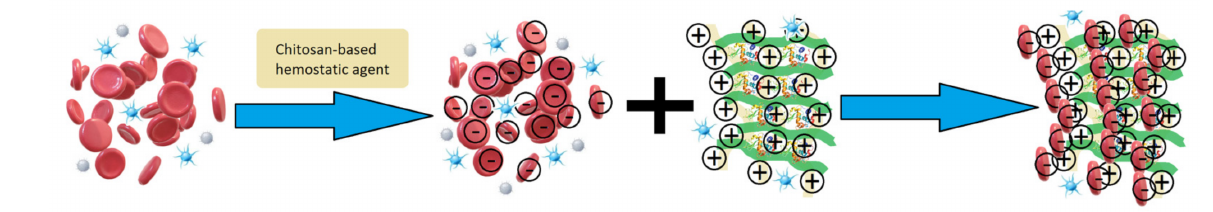
Figure 9. General scheme of hemostatic agent mode of